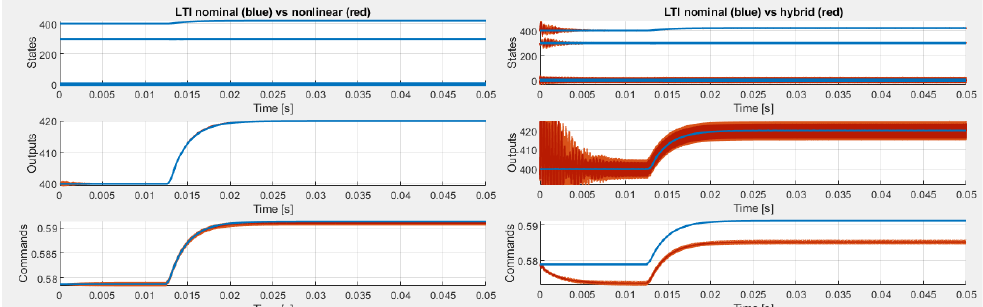
Figure 11. SEPIC-averaged state-space and hybrid model Monte Carlo closed loop simulations; due to a relatively low bandwidth imposed in order to obtain good stability margins and easily implementable controllers, all plants respond almost identically, although component tolerances reach values of ± 20%; the initial transients exist due to starting the simulations from the nominal equilibrium point only.